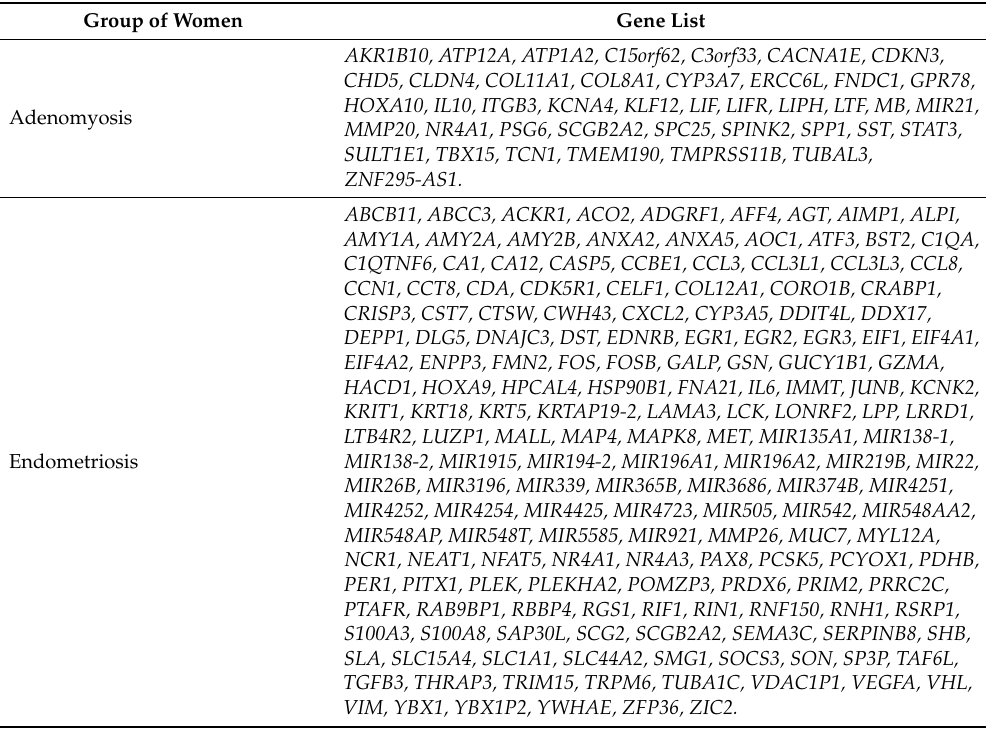
Gene lists associated with endometrial receptivity in women with adenomyosis or endometriosis and healthy women. Altered endometrial expression levels of genes and proteins in women with adenomyosis and endometriosis during the window of receptivity and biomarkers of uterine receptivity were retrieved from the literature survey. The gene nomenclature of extracted data was edited according to the HUGO Gene Nomenclature Committee (HGNC)